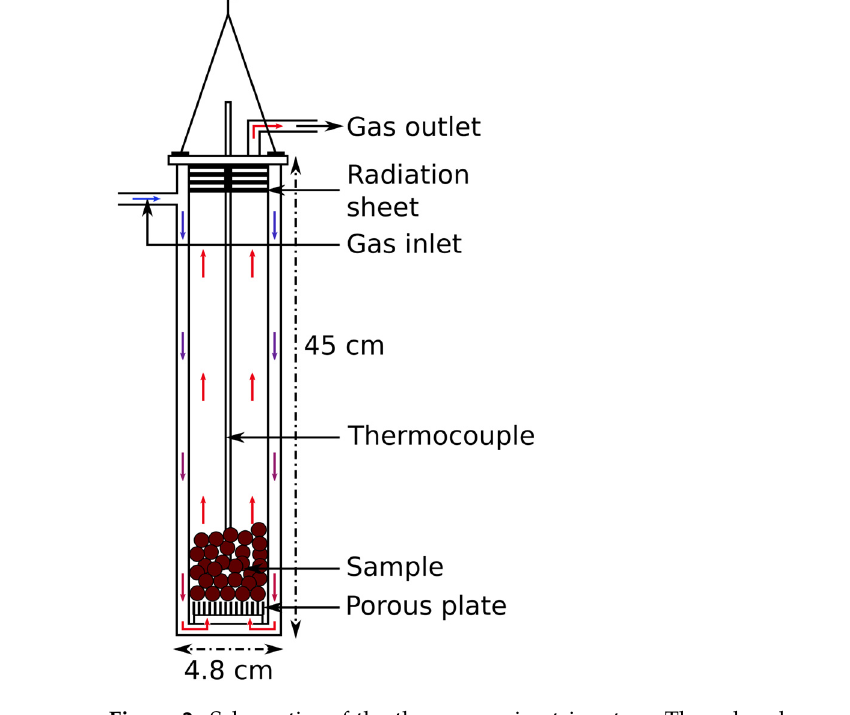
Figure 2. Schematics of the thermogravimetric setup. The colored arrows illustrate how the gas travels down the double wall and heats up before it reaches the sample at the bottom.